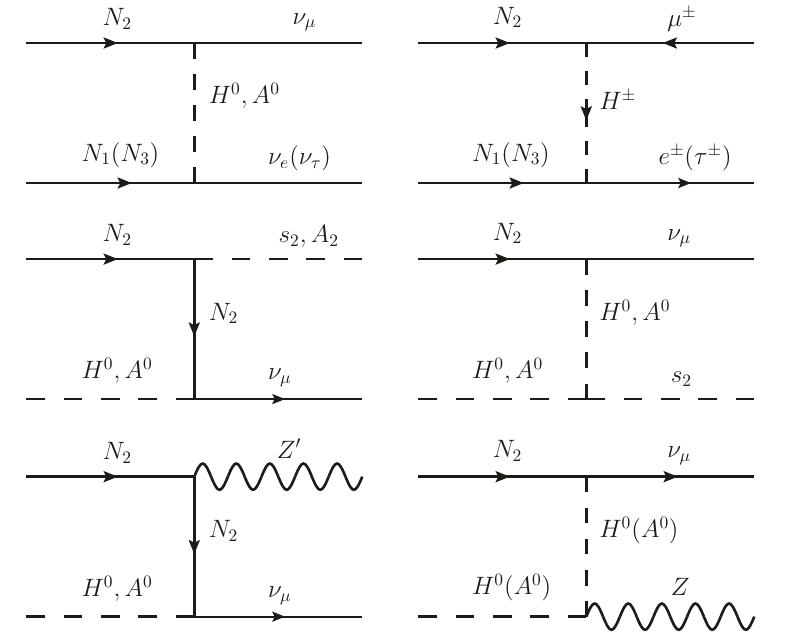
Figure 36 . Subleading Co-annihilation